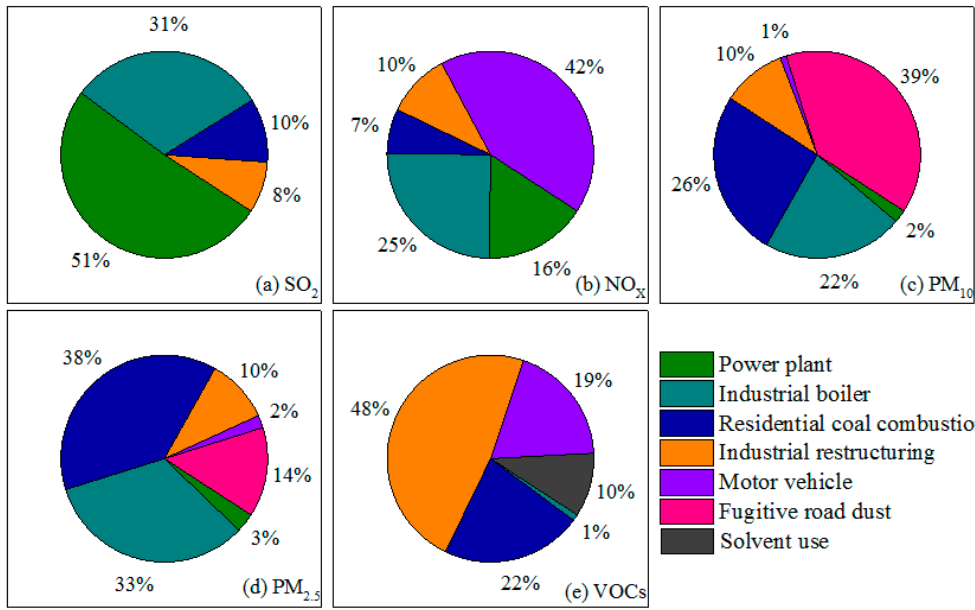
Figure 3. Contribution ratio of air pollutants emission reduction by control measures. SO 2 ( a ), NO x ( b ), PM 10 ( c ), PM 2.5 ( d ) and VOCs ( e ).